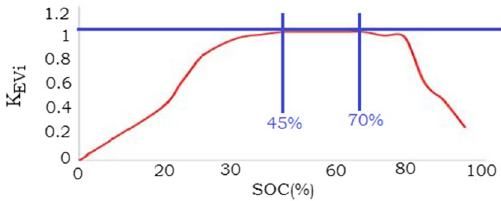
Fig. 2 Gain K EVi versus state of charge